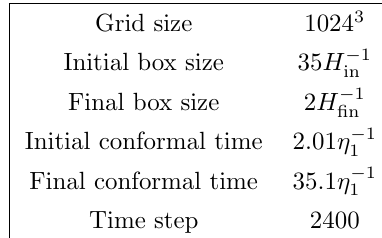
Figure 7 . A schematic picture of collision between the compensated string with ( n 1 ; n 2 ) = (1 ; 2) and the uncompensated string with ( n 1 ; n 2 ) = (1 ; 0) for (cid:12)gure 6. The red rod is a (cid:30) 1 -string with n 1 = 1. The green rod is a (cid:30) 2 -string with n 2 = 1. The arrows on the strings denote the magnetic (cid:13)ux in the strings. The strings are cut for drawing (cid:12)gures.